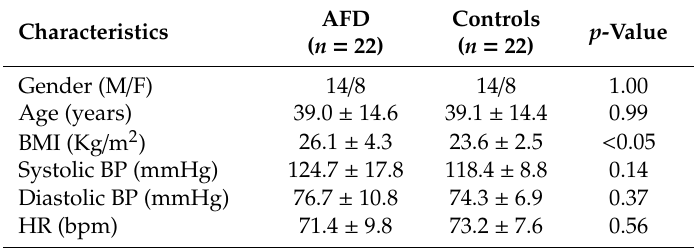
Table 1. Characteristics of the study population.